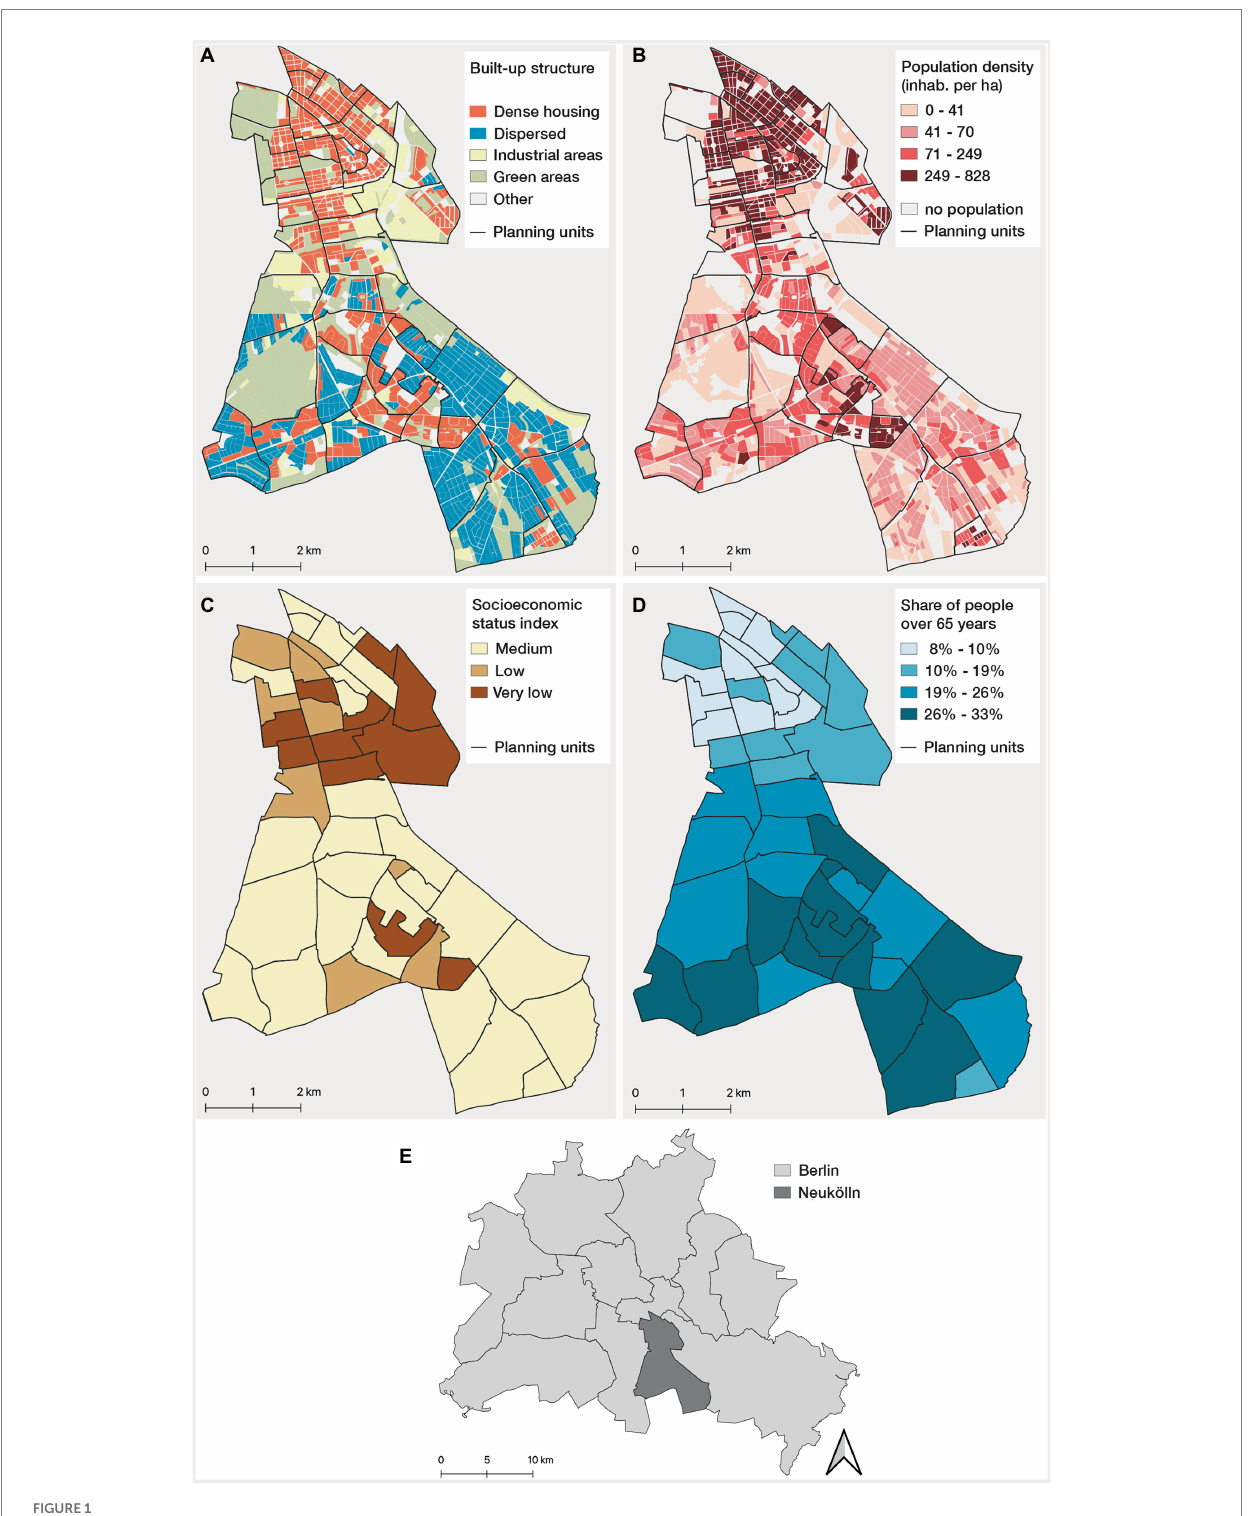
FIGURE 1 Built-up and demographic characteristics of Neukölln: (A) built-up structures at block level*, and (B) population density at block level*, (C) socioeconomic status index** (calculated on the basis of unemployment rate, child poverty and people receiving social benefits), and (D) share of people >65 years old at planning unit level; (E) location of Neukölln in Berlin. Data source: Senate for Building, Housing and Transport, Berlin (44) and Statistics Office of Berlin-Brandenburg (43). *The block level is the smallest subdivision of the Berlin urban area in the regional reference system (43). **There is also the class “high” in Berlin. But no planning units are classified as “high” in Berlin-